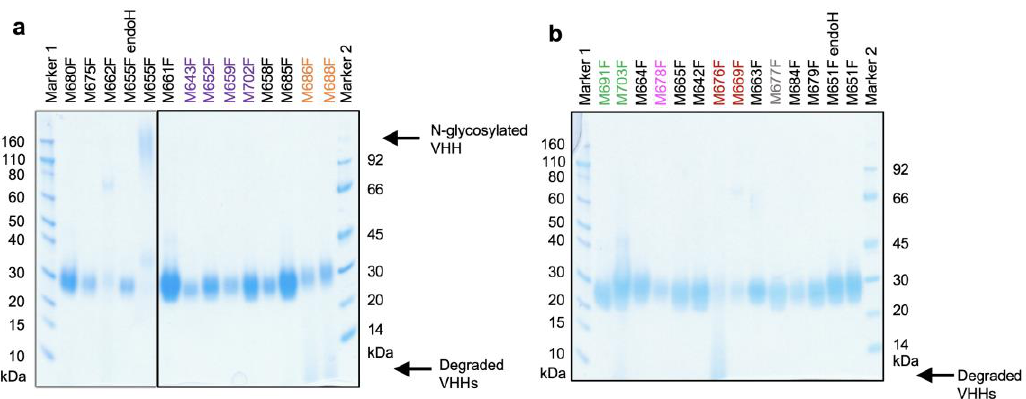
Figure 1. Analysis of yeast-produced VHHs by reducing SDS-PAGE. VHHs M651F and M655F, which contain potential N-glycosylation sites, were treated with endoglycosidase H (endoH). VHHs were analyzed on two gels (panels ( a , b )) and are arranged according to their CDR3 group. A single lane left of M661F was removed from panel a. Newly isolated VHHs of the same CDR3 group are indicated using the same color. The position of N-glycosylated M655F and degradation products of VHHs are indicated at the right. The molecular weight of markers used is indicated.